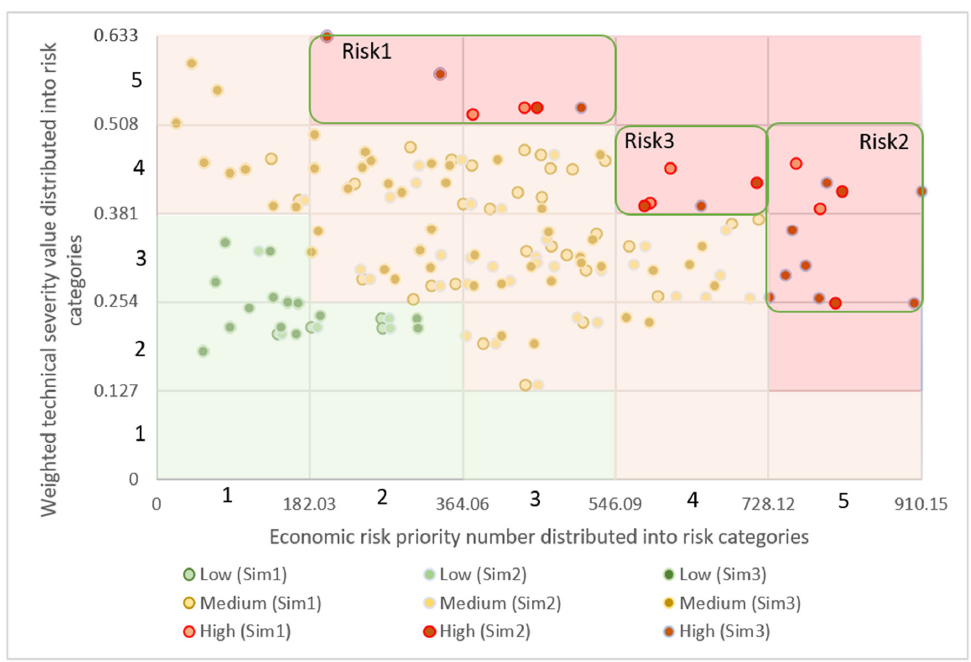
Figure 9. The positioning of the degradation factors’ risk categories on the risk matrix. “Risk1” is the group with the highest SV and concerns three unique degradation factors relevant for all simulations and one degradation factor relevant for simulation 1. The freezing of adhesive during the curing process (M9b), relevant for simulation 1, has a strong influence on the adhesion